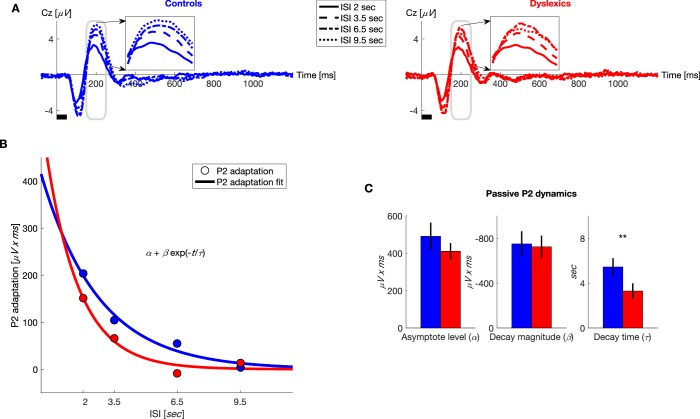
Under passive conditions, dyslexics’ P2 adaptation is shorter than controls’.(A) Grand average ERPs, plotted separately for blocks with different ISIs, for controls (blue, left) and dyslexics (red, right). Insets: P2 range enlarged. Dyslexics’ P2 area was largest for the 6.5 s ISI, whereas controls’ P2 was largest for the 9.5 s ISI. (B) The magnitude of P2 adaptation as a function of time from the previous stimulus (ISI) under passive condition (circles) fitted with an exponential decay model (solid line). Controls in blue; dyslexics in red. (C) Groups’ mean and SEM of individually fitted estimated parameters of P2 recovery from adaptation. Dyslexics differed from controls only in the estimated rate of decay (p<0.005).